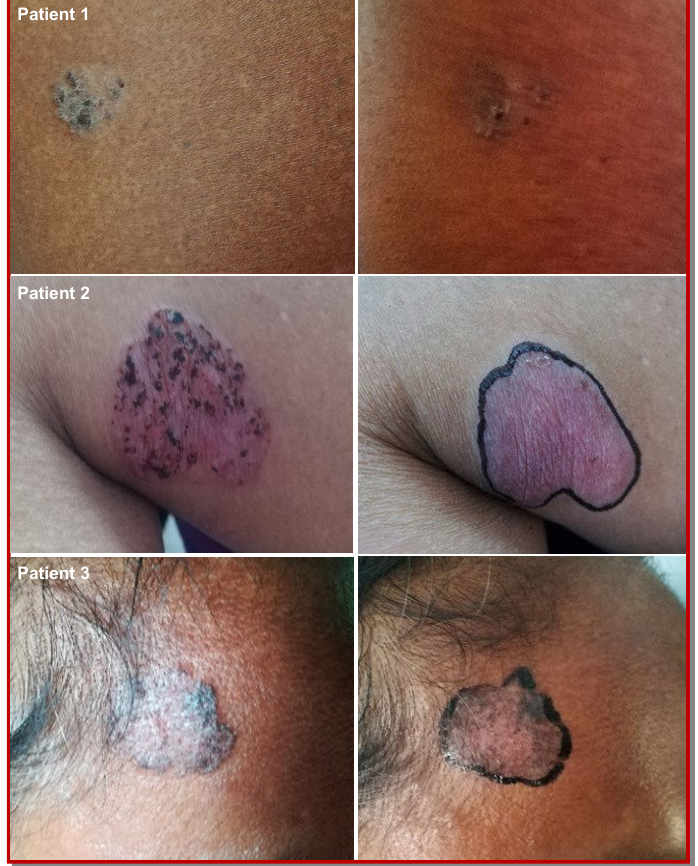
Figure 1: Photographs show the effectiveness of the extract of three pa- tients of Bowen’s disease. Left column represents before treatment and right column represents after